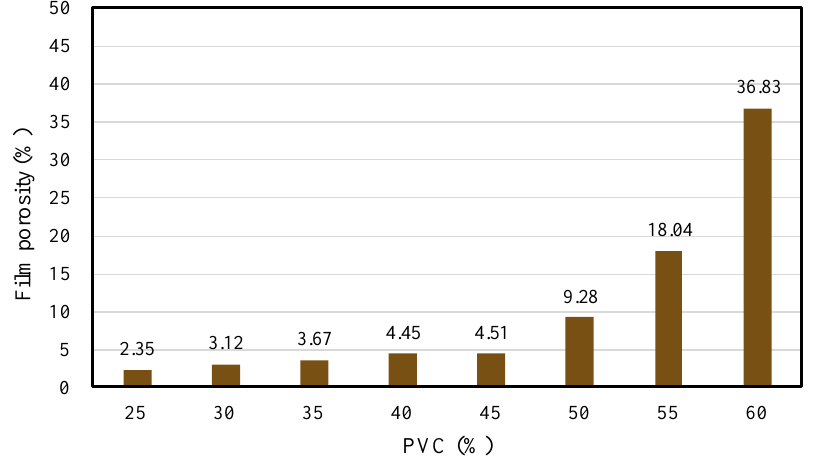
Figure 5. Effect of PVC on porosity of paint’s film.